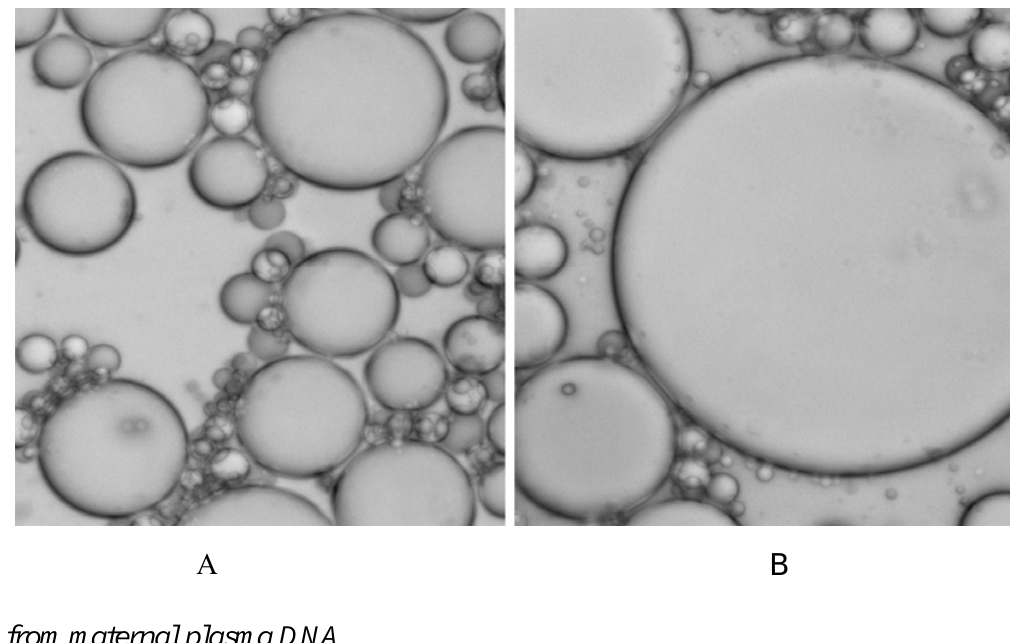
Figure 2. Thermal instability of certain emulsion